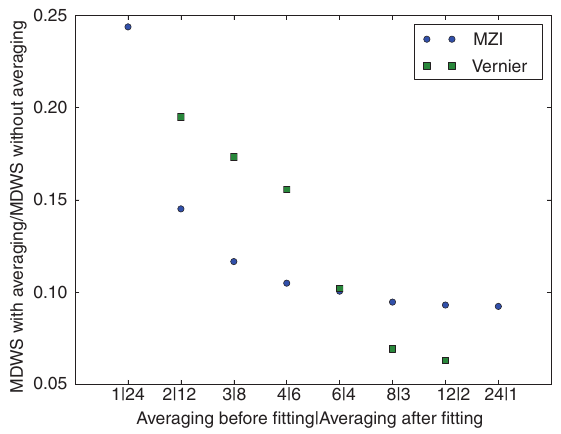
Figure 8: Minimum detectable wavelength shift (MDWS) improve- ment through averaging for the MZI (circles) and the Vernier (squares), all with averaging over 24 data points, spread out differ- ently before versus after fitting the data.